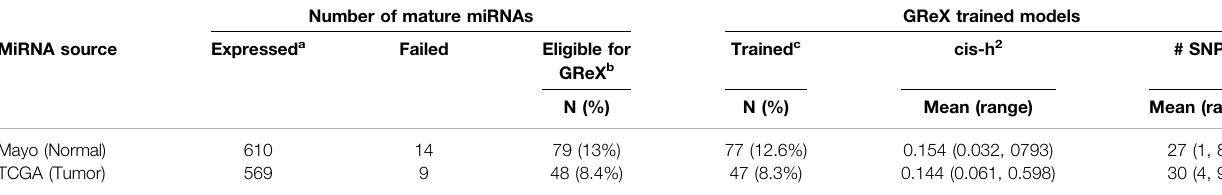
TABLE 1 | Summary of miRNA GReX model training for tumor and normal expression datasets.